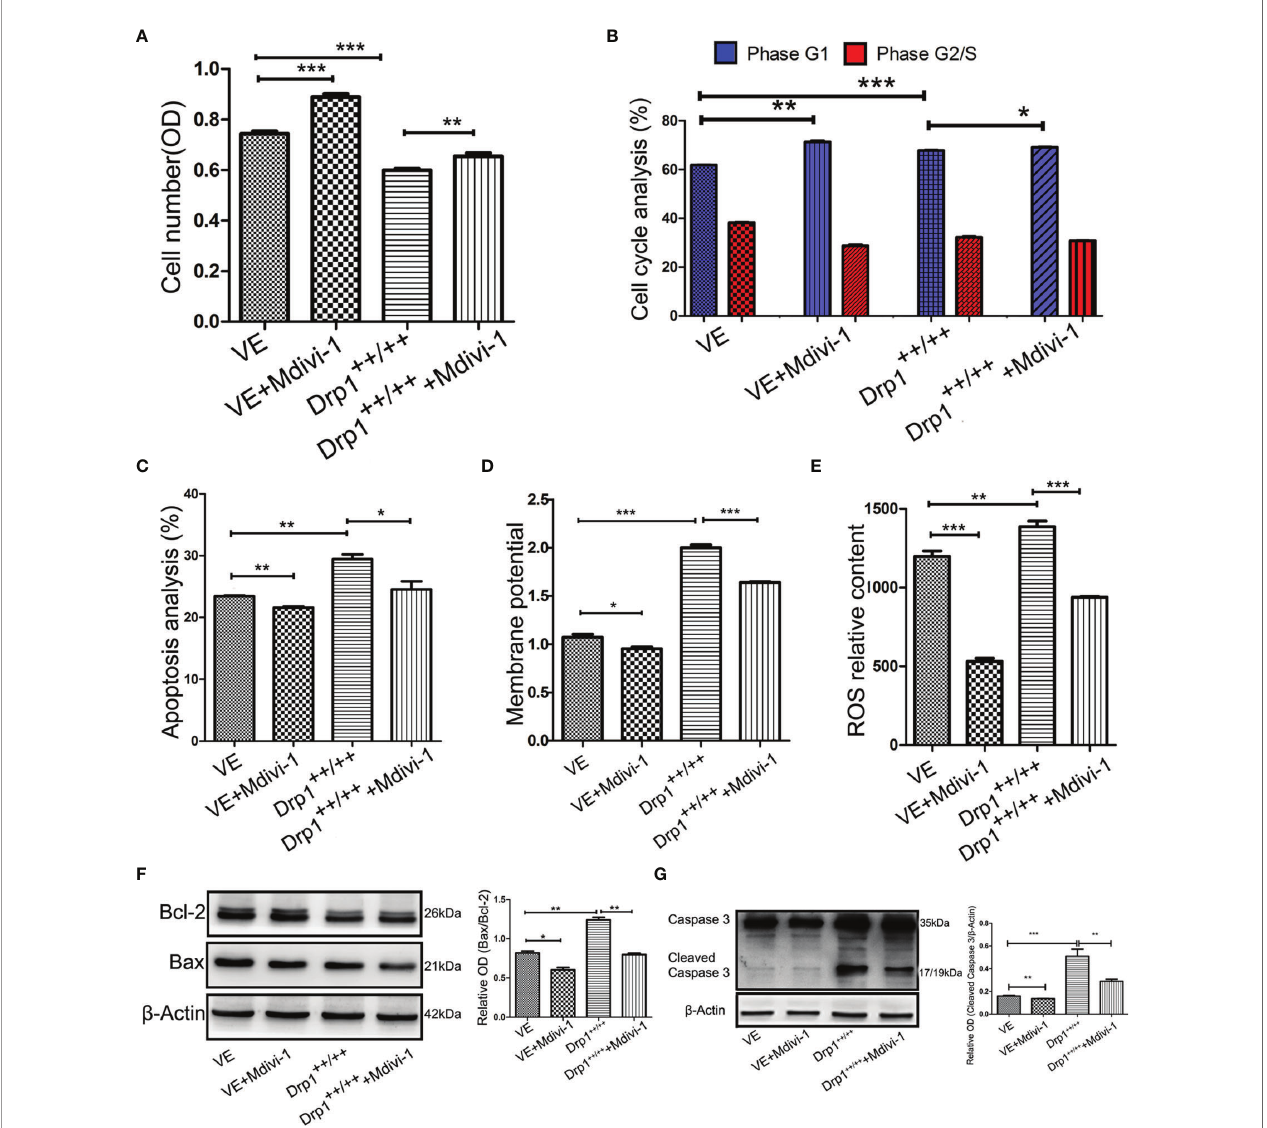
FIGURE 4 | Inhibition of Drp1 promoted proliferation of GH3 cells. (A) The number of GH3 cells in four groups (VE, VE+Mdivi-1, Drp1 ++/++ , Drp1 ++/++ +Mdivi-1) at 48 h were assessed by CCK-8 assay (n = 3). (B) Cell cycle at 48 h were analyzed by fl ow cytometry (n = 3). (C) Cell apoptosis at 48 h were analyzed by fl ow cytometry (n = 3). (D) Mitochondrial membrane potential of four GH3 cell groups were detected by fl ow cytometry using Rhodamine123 at 48 h (n = 3). (E) Reactive oxygen species (ROS) were detected by fl ow cytometry using DCF-DA fl uorescence at 48 h (n = 3). (F) The expression of Bcl-2 and Bax proteins were detected by western blotting (n = 3) (left panel). Statistical analysis of the western blotting results (right panel). (G) The expression of cleaved caspase-3 protein was detected by western blotting (n = 3) (left panel). Statistical analysis of the western blotting results (right panel). *P < 0.05, **P < 0.01, ***P < 0.001. Data were expressed as mean ±